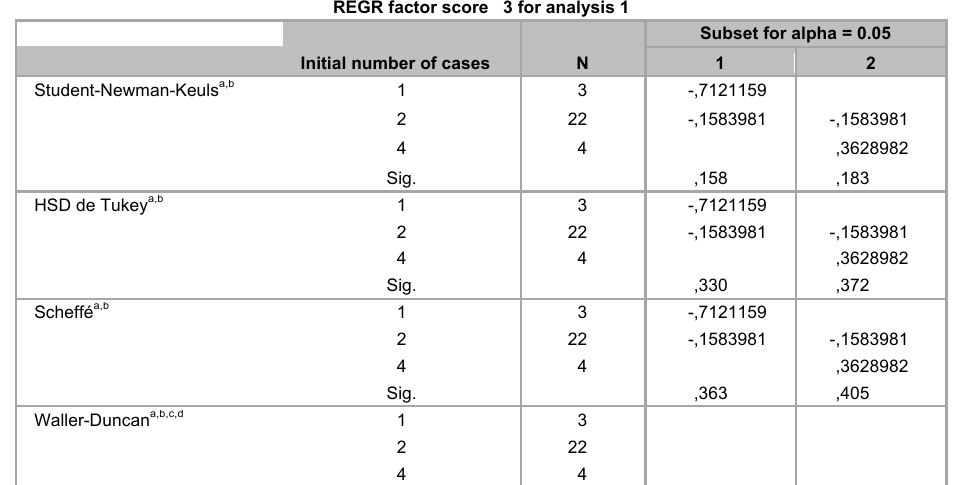
Post-hoc tests for Factor 3, Intellectual property and innovation results REGR factor score 3 for analysis